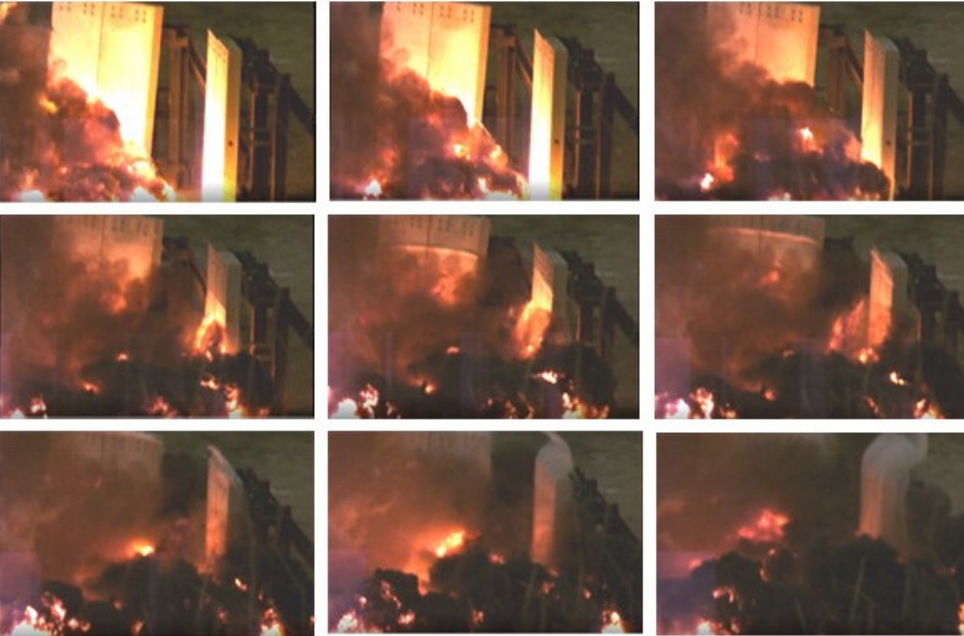
Figure 9. Footage of the blast wave of 60 kg RIODIN Dynamite at 5 m (test